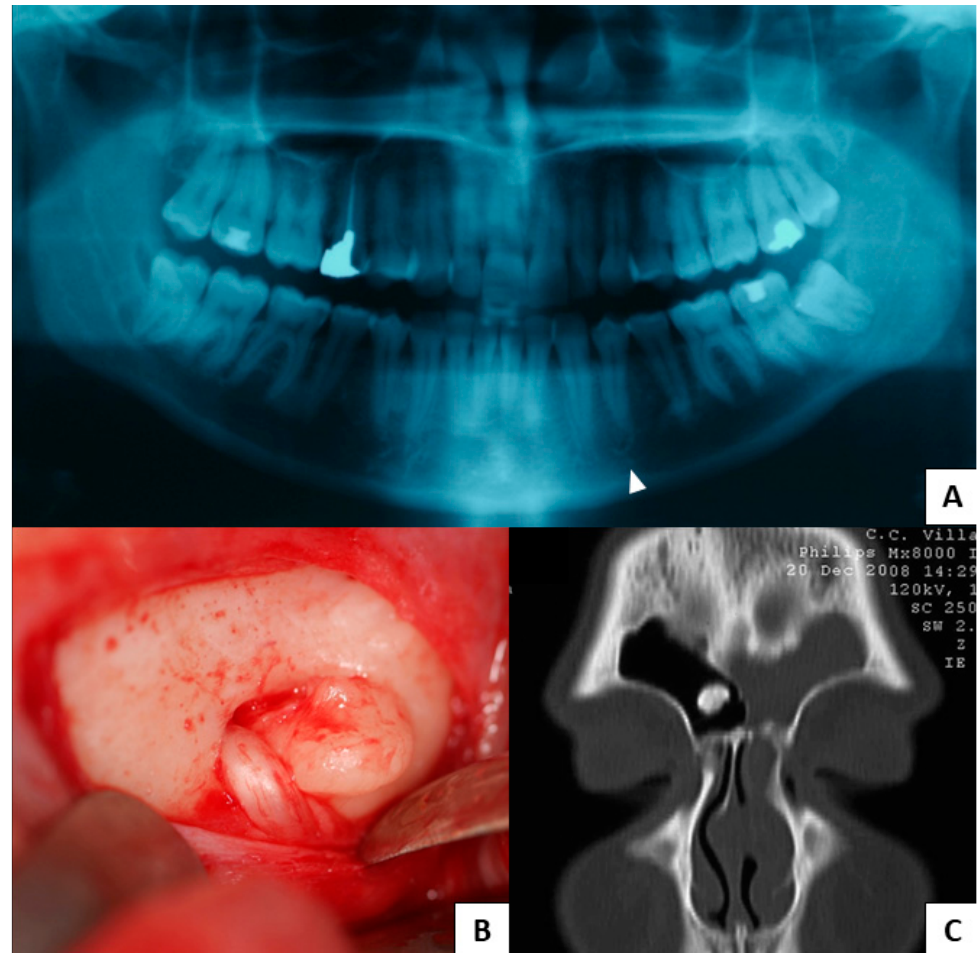
Figure 4. Clinical Case 2. ( A ) A GS patient complaining of pain in lower alveolar nerve region shows an anomaly of the ipsilateral mental foramen in panoramic radiogram (arrow); ( B ) intraoperative image of the osteoma associated with the nerve; ( C ) the same patient also showed an osteoma of the frontal sinus.